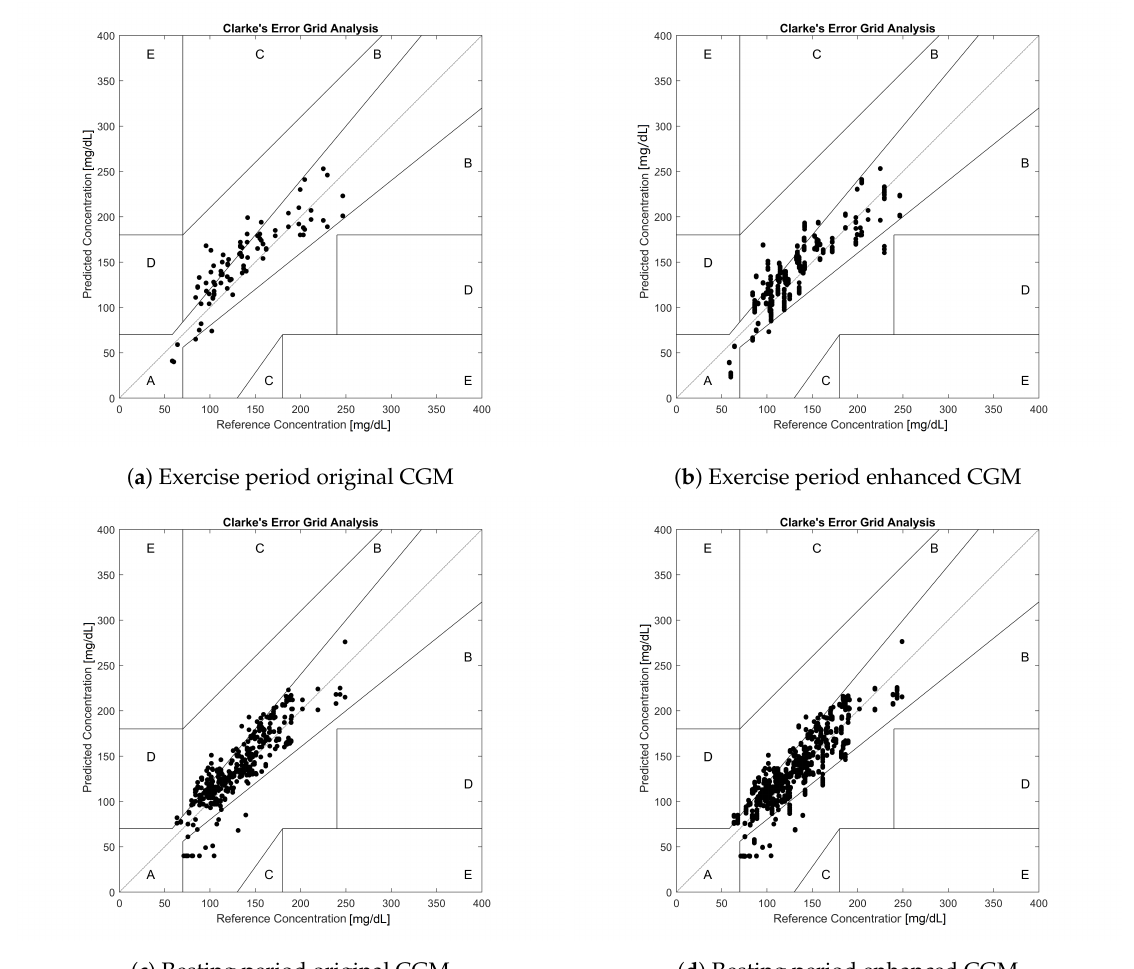
Figure 3. Clarke error grid analysis for the wearable-enhanced CGM data. ( a ) Subset of CGM-PG pairs before enhancement during the physical activity period. ( b ) Subset of CGM-PG pairs after enhancement with exercise monitoring devices during the physical activity period. ( c ) Subset of CGM-PG pairs before enhancement during the resting period. ( d ) Subset of CGM-PG pairs after enhancement with exercise monitoring devices during the resting period.